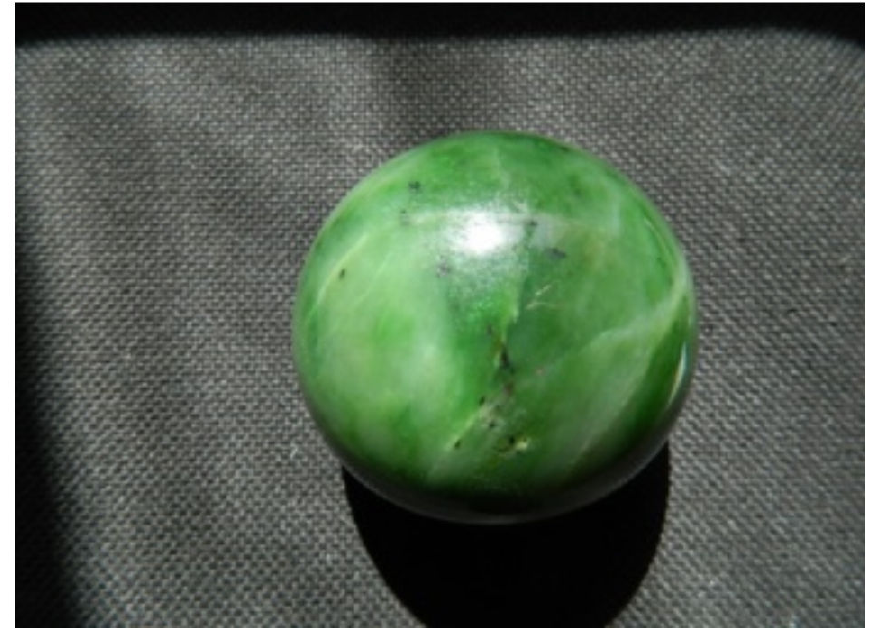
Figure 6. Ball of nephrite from the Bazhenovskoye deposit. The chemical composition of the nephrite from the Bazhenovskoye deposit (Table 4) is similar to that of serpentinite type nephrite from known deposits